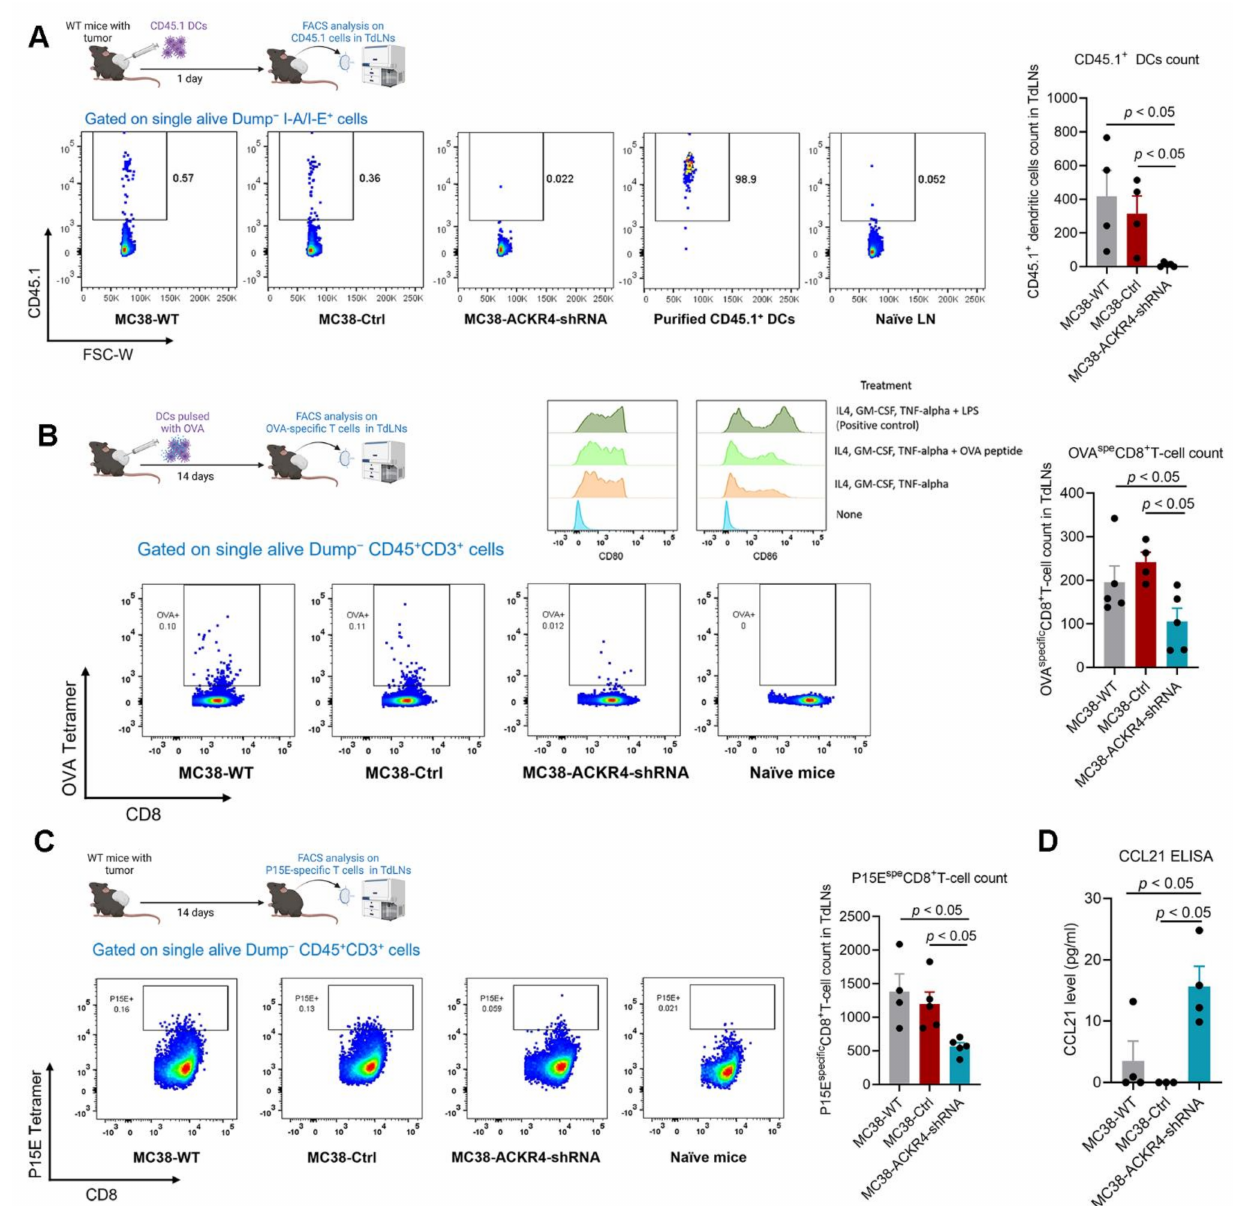
Figure 4. ACKR4 expression and DC migration and T-cell priming. ( A ) Enriched CD45.1 + DCs were injected into the MC38 tumor and analyzed in TdLNs 1 day post-injection. ACKR4 knockdown in MC38 tumor cells impaired DC migration from the tumor to the TdLNs ( n = 4). ( B ) DCs loaded with OVA antigens were injected into the MC38 tumor microenvironment, and the OVA-specific CD8 + T-cells were analyzed in the TdLNs. ACKR4 knockdown in MC38 tumor cells impaired DC mediated T-cell priming ( n = 4–5). The histogram shows CD80 and CD86 expression on DCs used in the study. ( C ) P15E (a tumor-associated antigen in MC38 cells)-specific CD8 + T-cell counts in TdLNs of MC38 tumors with various ACKR4 expression levels ( n = 4–5). ( D ) CCL21 quantification in MC38 tumors with different ACKR4 expression levels ( n = 3–4). (For more than two group statistical analyses, the uppermost p -value indicates the ANOVA-analysis, and other p -values indicate the posthoc analysis between two specific groups. DCs: Dendritic cells, OVA: Ovalbumin, CD8: Cluster of differentiation 8, CD3: Cluster of differentiation 3, CD80: Cluster of differentiation 80, CD86: Cluster of differentiation 86, CCL21: Chemokine (C-C motif) ligand 21, FACS: Fluorescence-activated cell sorting, TdLNs: Tumor-draining lymph nodes, P15E: Murine leukemia virus envelope protein P15E, FSC-W: Forward light scatter width, CD45.1: Cluster of differentiation 45.1, CD45: Cluster of differentiation 45, WT: Wild type, Ctrl: Control, shRNA: Short hairpin RNA, IL4: Interleukin 4, GM-CSF: Granulocyte-macrophage colony-stimulating factor, TNF: Tumor necrosis factor, LPS: Lipopolysaccharides, Spe: Specific, ANOVA: Analysis of